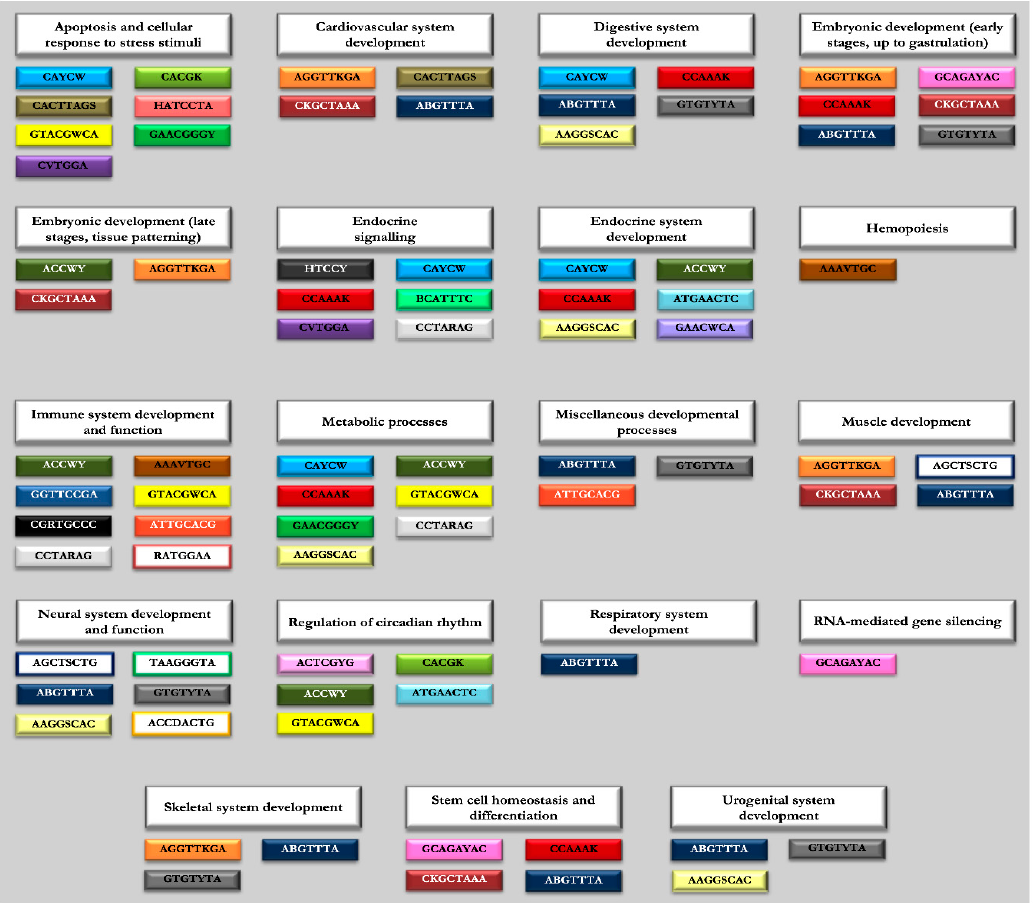
Figure 3. Schematic representation of the enriched functions for PIWI-interacting RNA (piRNA) motifs. The scheme provides an overview of the motifs associated with each functional cluster derived from the computational pathway analysis (based on GeneMANIA tool) of transcription factors (TFs) sharing the same domains with piRNAs (see text for details). A specific colored box is assigned to each piRNA motif.